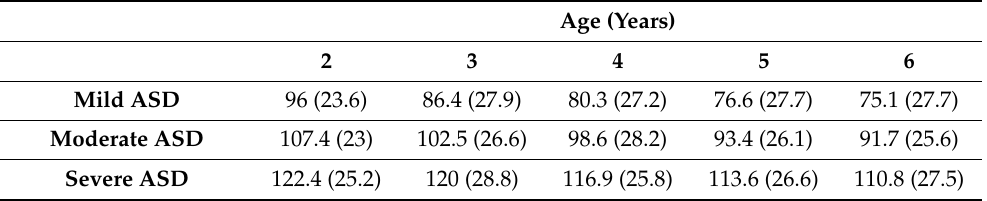
Table 8. Averaged Total ATEC + MSEC score for the mild, moderate, and severe ASD groups. A lower score indicates symptom improvement. The data are presented as the mean (SD).